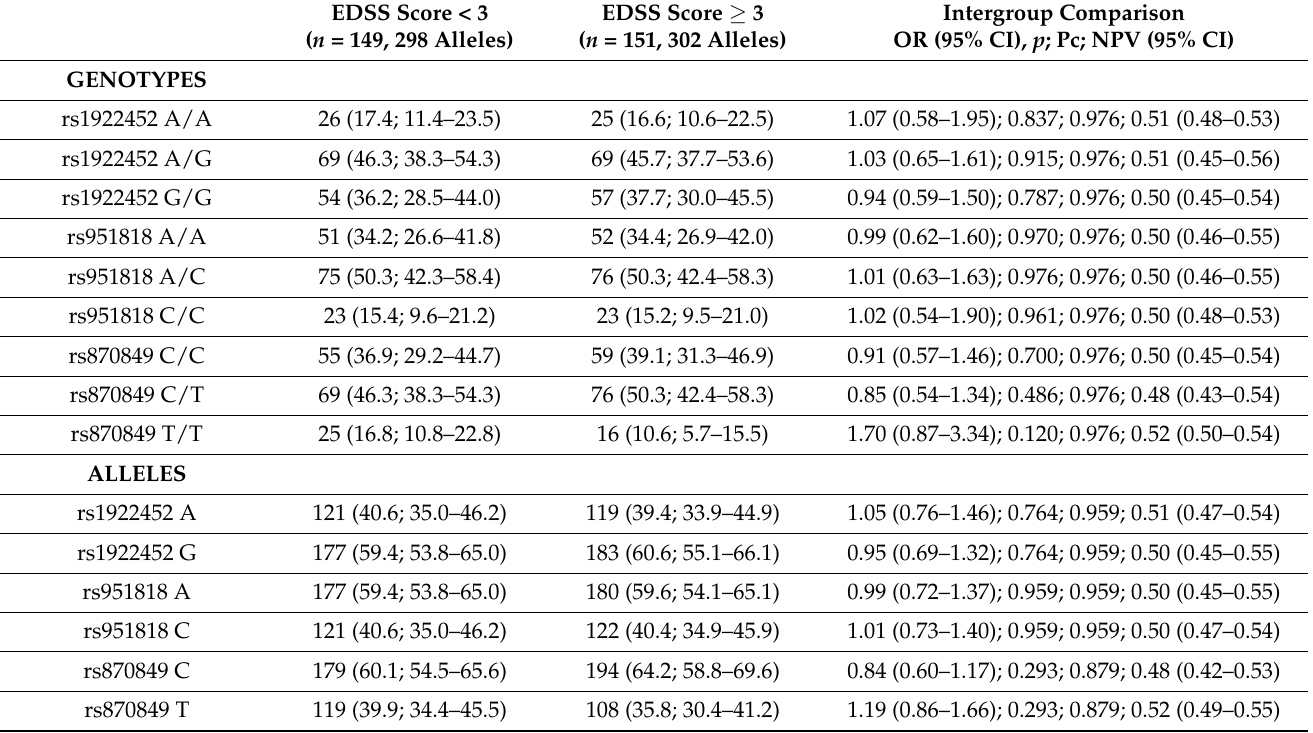
Table 4. Genotypes and allelic variants of patients with MS according to the EDSS scores. The values in each cell represent the number (percentage; 95% confidence